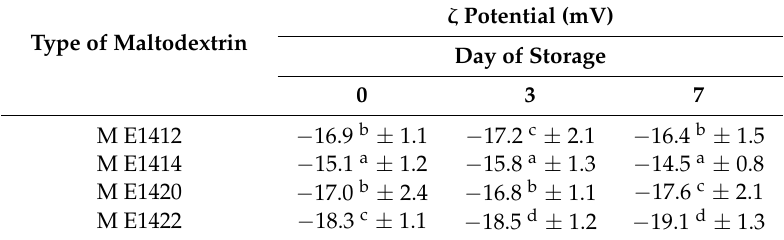
Table 1. Changes of the ζ potential values of emulsions with addition of DE 6 maltodextrin during storage.